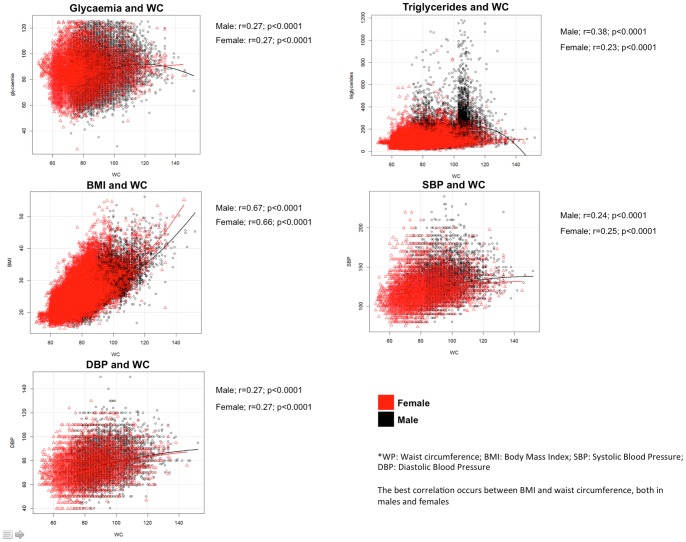
Relations of waist circumference with glycaemia, triglycerides, BMI and blood pressure by age categorized by gender.